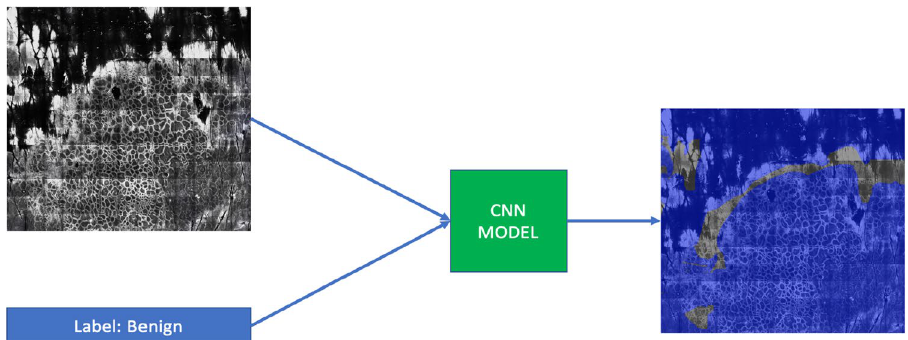
Figure 1. A visual description of weakly supervised learning—a convolutional neural network (CNN) model receives the image and an image-level label as input, and produces as an output pixel-level annotations, represented by the blue here. Regions that were not labeled by the expert readers are not colored. The block diagram is prepared using Powerpoint 16.44 (https ://insid er.offic e.com/en-us/relea senot es/mac/slow/versi on-16-44-build -20120